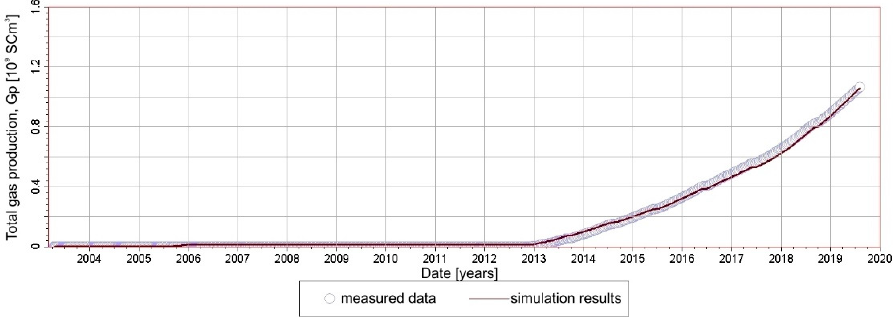
Figure 9. Total reservoir oil production.